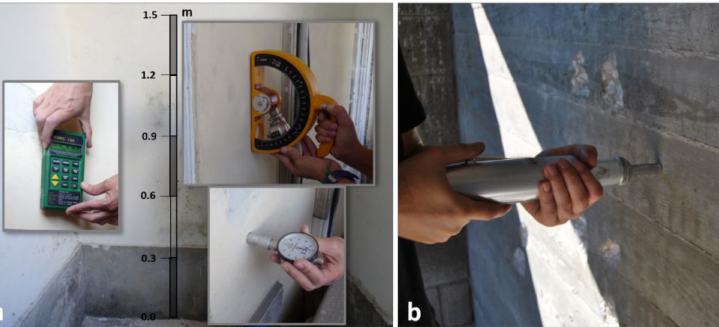
Figure 4. In situ tests. ( a ) Example of a vertical profile to assess moisture, surface hardness, and mechanical strength of renders in a wall. Portable hygrometer, middle left; pendulum sclerometer, top right; shore durometer, bottom right; ( b ) Rebound Schmidt hammer test on a concrete surface. Table 2 refers to a qualitative classification based on old render studies for hardness and mechanical strength [45] that was adopted in this work. Table 2. Qualitative classification for hardness and mechanical strength according to Tavares (2009) [45]. Shore A